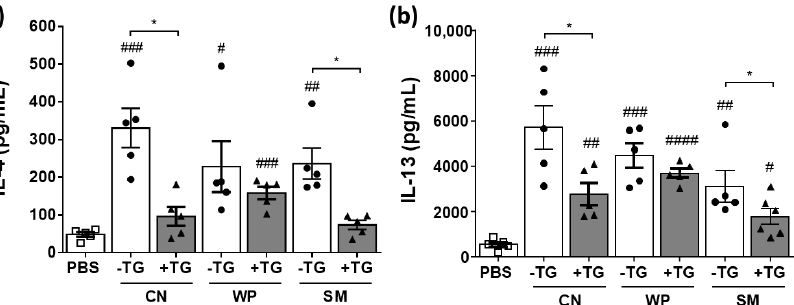
Figure 4. Stimulation of splenocytes. Th2 cytokines ( a ) IL-4 and ( b ) IL-13 released from cultures of spleen cells from casein (CN), whey protein (WP), and skim milk (SM) sensitized BALB/c mice ( n = 5) stimulated with CN, WP, and SM, either untreated (white bars) or treated with TG (grey bars). Pounds and asterisks indicate, respectively, statistically significant differences with respect to cells stimulated with PBS or between both experimental groups. Data are expressed as mean ± SEM. # and * p < 0.05, ## p < 0.01, ### p < 0.001, #### p <